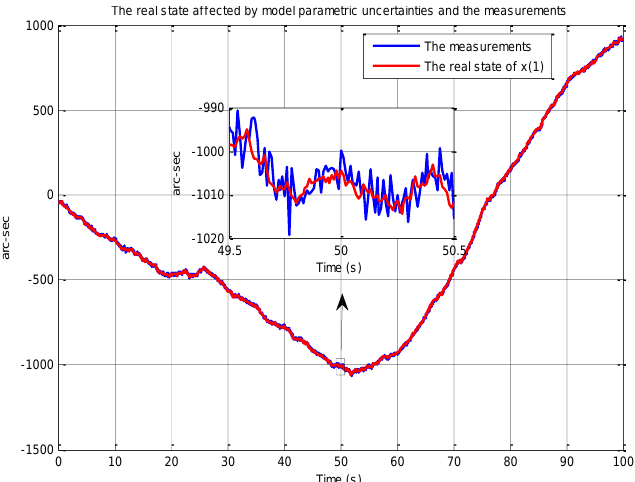
Figure 3. The real state affected by model parametric uncertainties and the measurements.